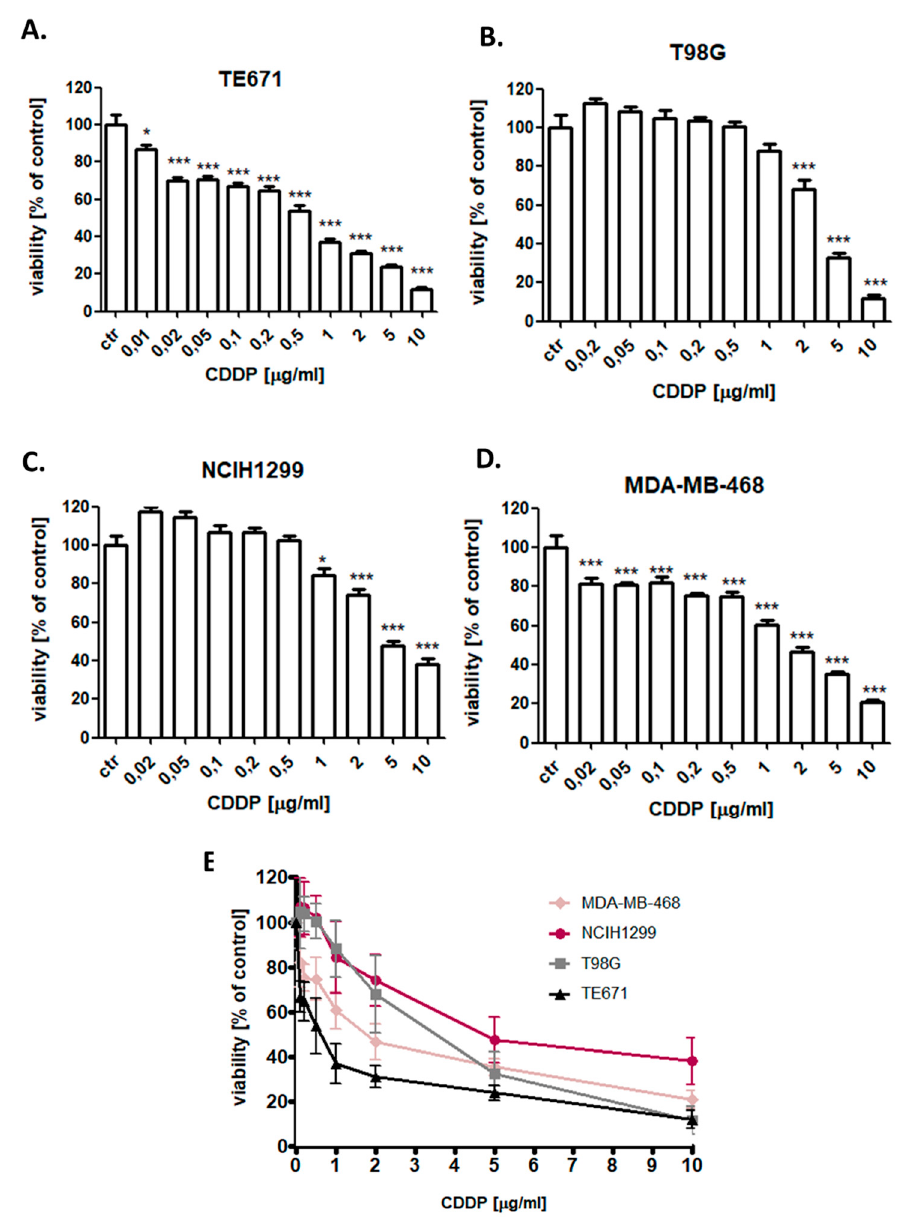
Figure 3. The anti-proliferative effects of cisplatin (CDDP) in ( A ) TE671 ( B ) T98G ( C ) NCIH1299 ( D ) MDA-MB-468 and ( E ) all analyzed cancer cell lines after 96 h treatment with various concentrations (0.01–10 µg/ml) of an active agent. The cell viability was measured by the MTT assay. Results were analyzed using GraphPad Prism 5.0 software (one-way ANOVA; Tukey post-hoc testing). Statistical differences were considered relevant at p < 0.05 (* p < 0.05, *** p < 0.001). Data are expressed as mean ± standard deviation of the mean (± SD); n = 24 per concentration from three independent experiments.